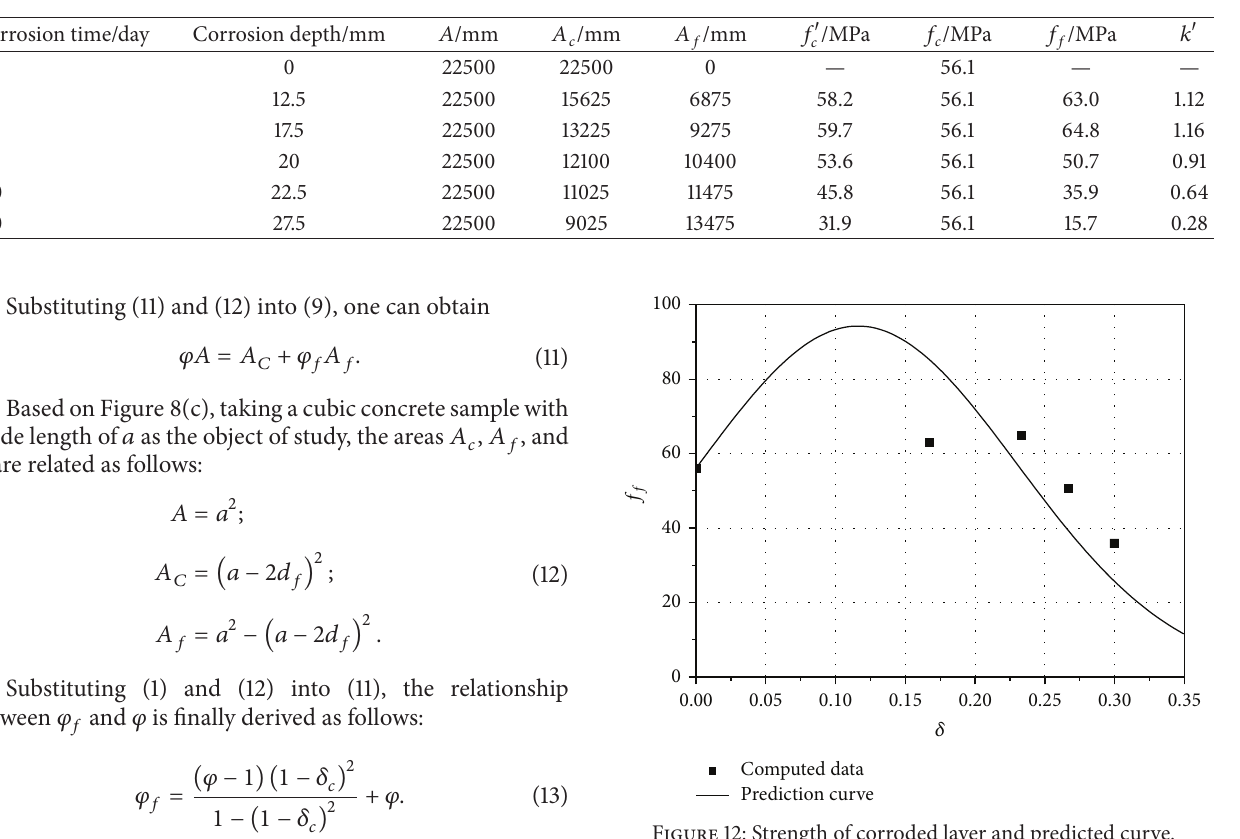
Table 9: Calculated results of the compressive strength of corroded concrete layer.